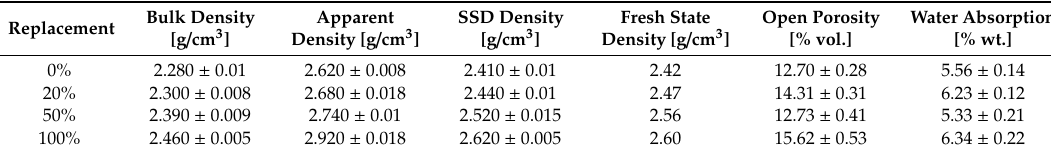
Table 4. Physical properties of hardened concrete